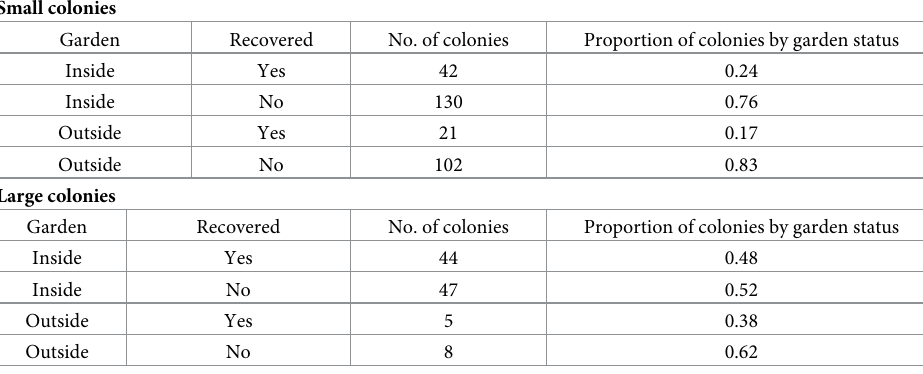
Outside 0.62 The proportion of surviving colonies that either did or did not recover to at least their initial amount of live tissue after a year as a function of colony size and farmerfish garden